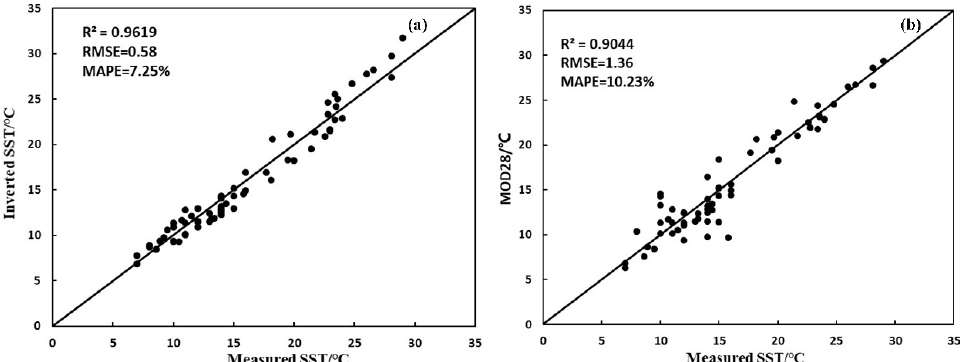
Figure 2. Calibration and validation of SST inversion algorithm and MOD28 to estimate sea surface temperature. Where, ( a ) is the validation of the remote sensing inversion results with the measured data; ( b ) is the validation of the SST product MOD28 with the measured data.